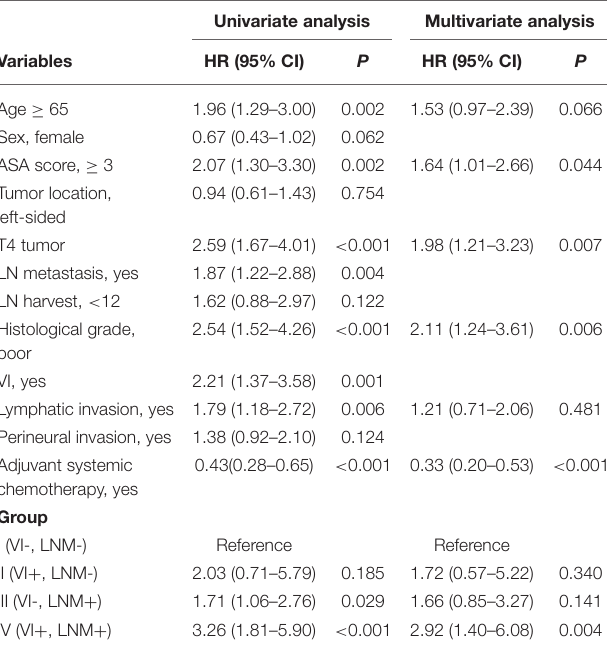
TABLE 3 | Disease-free survival in stage I-III colon cancer patients. TABLE 4 | Overall survival in stage I-III colon cancer